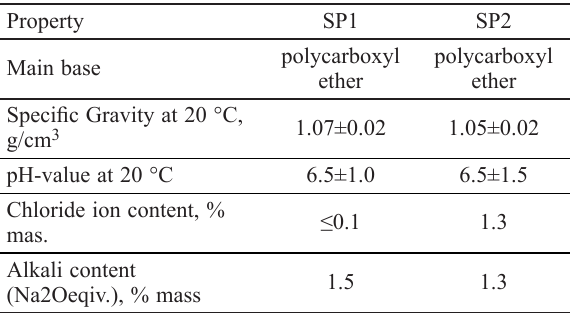
Table 1. The properties of superplasticizers Property